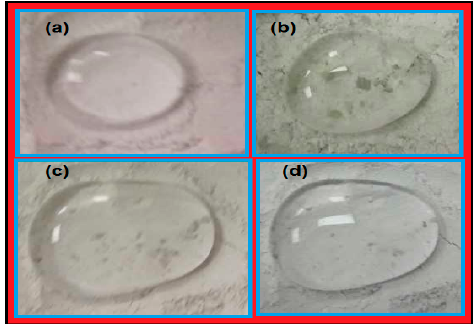
Figure 6. Photos of water on the treated sand with EOSNP1 prepared in the presence of different wt % of PWs ( a ) 20 wt %, ( b ) 10 wt %, ( c ) 5 wt %, and ( d ) 1 wt %.